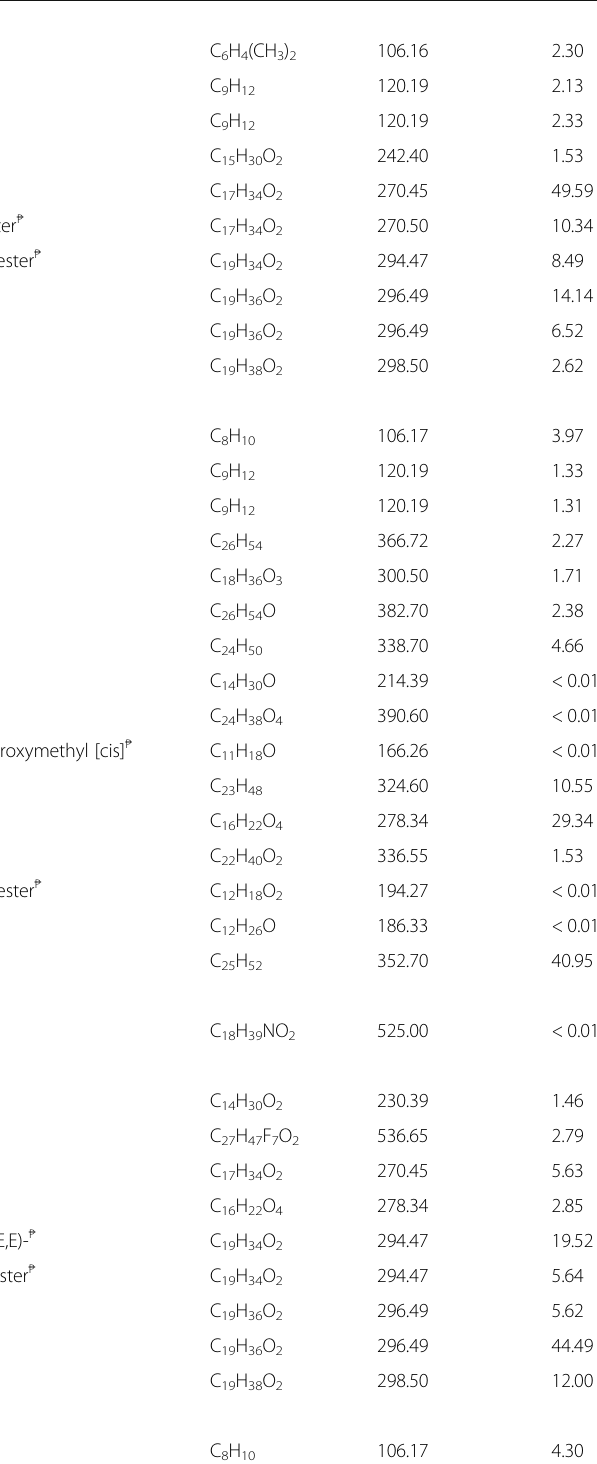
Table 4 Phytocomponents of (A) petroleum ether extract of A . occidentale , (B) ethylacetate extract of A . occidentale , (C) n -hexane extract of P . guajava , (D) chloroform extract of P . guajava , (E) ethylacetate extract of P . guajava , and (F) ethylacetate extract of T . catappa